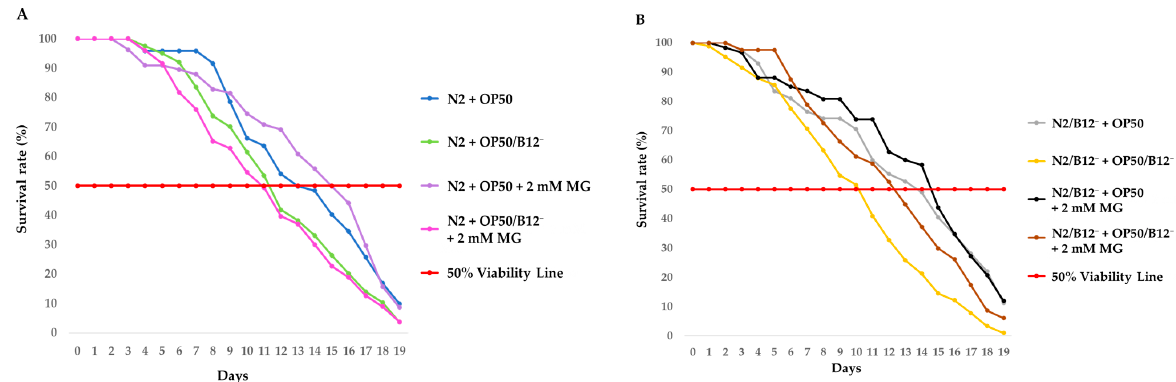
Figure 2. Lifespan of N2 and N2/B12 − worms. Synchronized N2 ( A ) and N2/B12 − ( B ) worms at the L4 stage were fed with either OP50 or OP50/B12 − with or without 2 mM mogrosides (MG). The percentage viability of N2 and N2/B12 − worms was plotted from day 0 to day 19. Three independent lifespan experiments were performed, and the results were used to calculate the average time at which 50% of worms survived. Statistical significance was compared to N2 worms + OP50 ( A ) or N2/B12 − worms + OP50/B12 − ( B ) and defined by the logrank test.